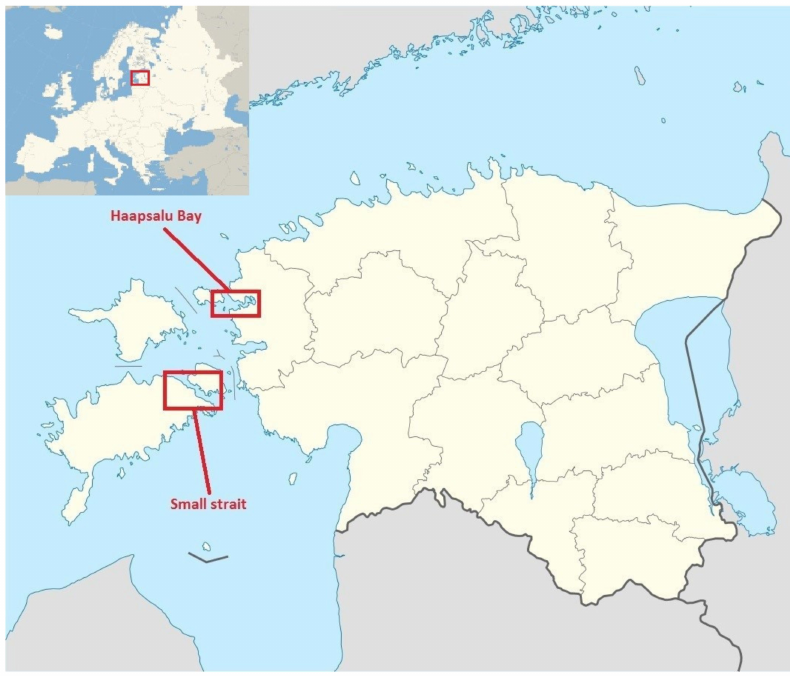
Figure 1. The location of two study sites; Haapsalu Bay and Small